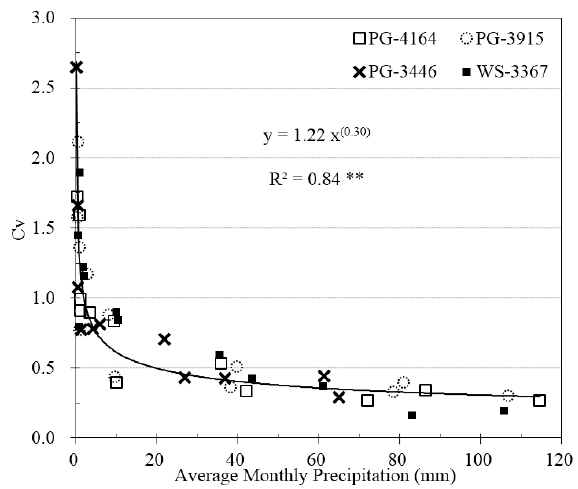
Figure 3. Correlation between Cv and average monthly precipitation during 2009–2015. The trend line was derived from data from all four sites, whereas that of the single site is not shown. The superscript ‘**’ indicates statistical significance at the 99% confidence level.